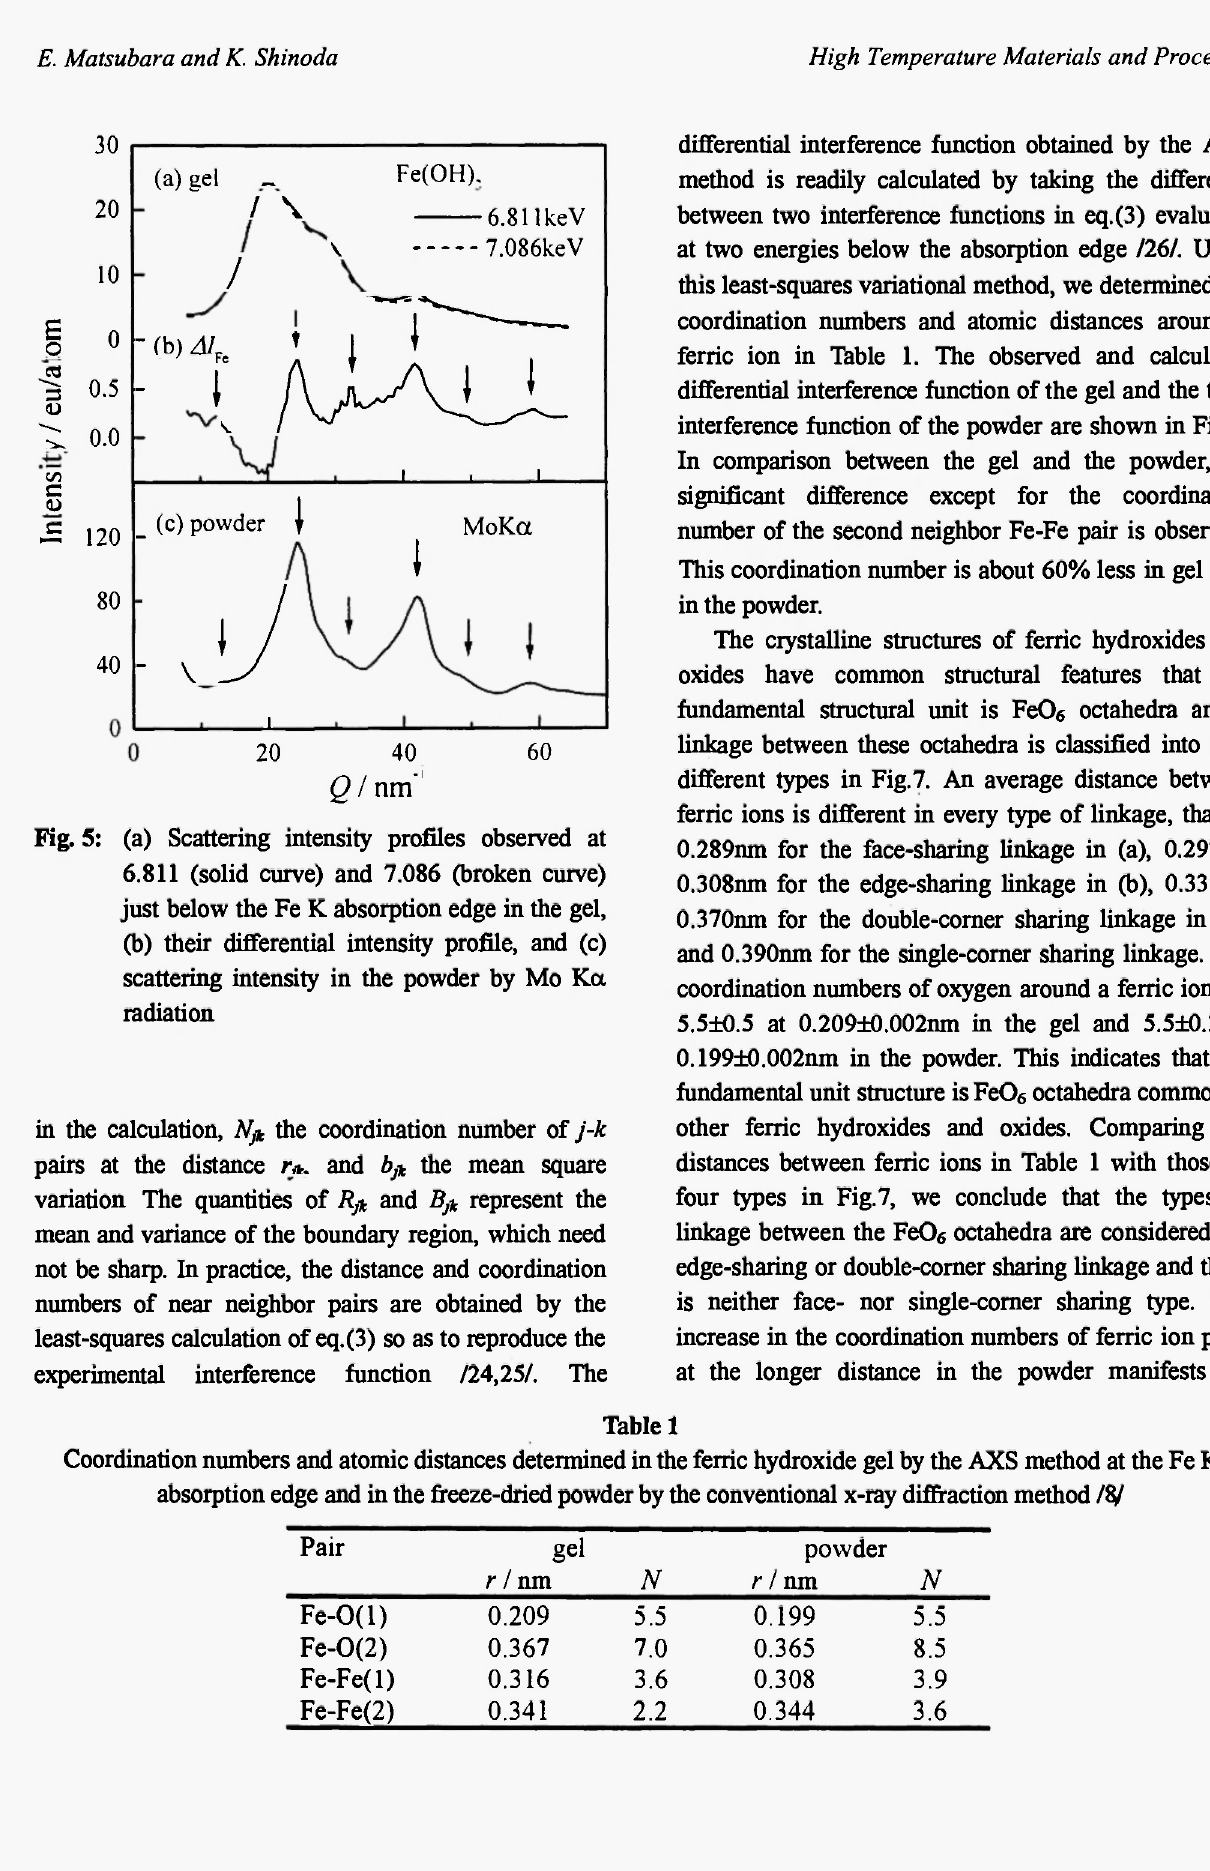
in the calculation, N pairs at the distance and b